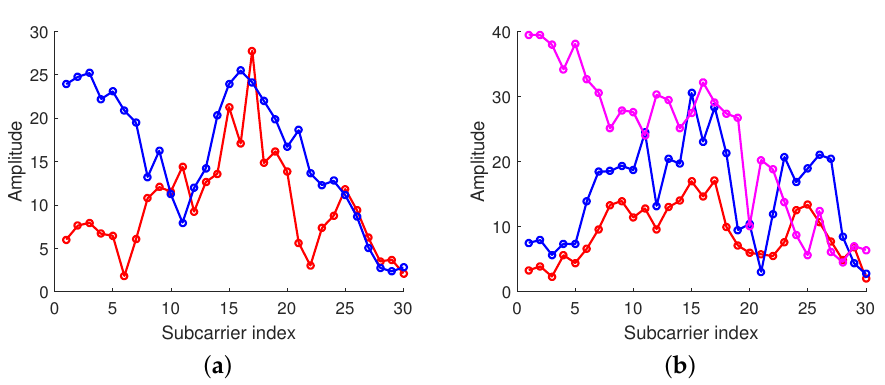
Figure 3. Fingerprints at differant locations. ( a ) Fingerprints at location a. ( b ) Fingerprints at location